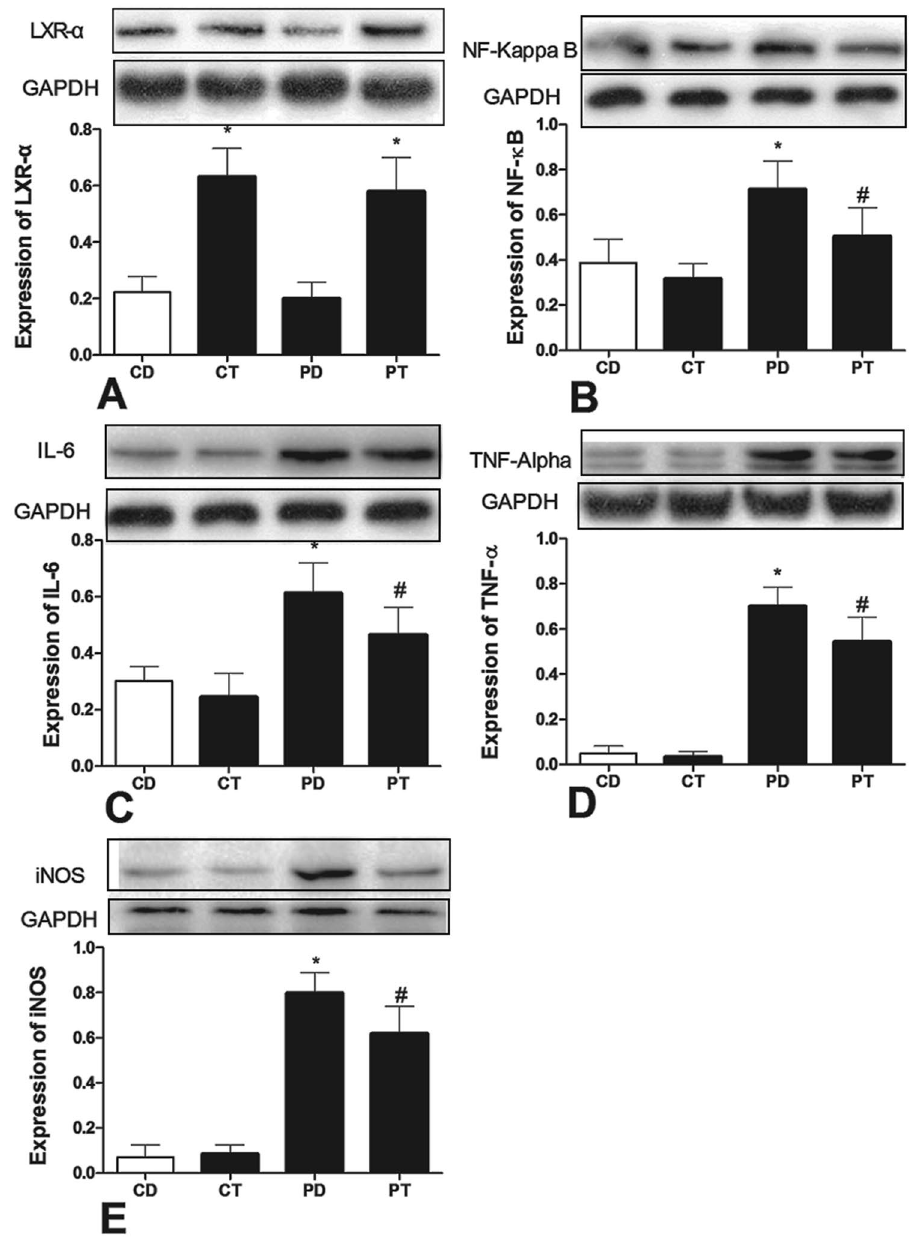
Figure 5. Effects of LXR antagonist administration on protein expression. Western blot examinations revealed changes in LXR α ( A ), NF- κ B ( B ), TNF- α (C), IL-6 ( D ), and iNOS ( E ) protein expression in rats. Samples were obtained from rat right ventricular myocardiocytes. (CD: rats treated with NS + DMSO, CT: rats treated with NS + T0901317, PD: rats treated with MCT + DMSO, PT, rats treated with MCT + T0901317). (n = 6, Δ : vs CD/PD P < 0.05, * vs CD P < 0.05, # vs PD P <